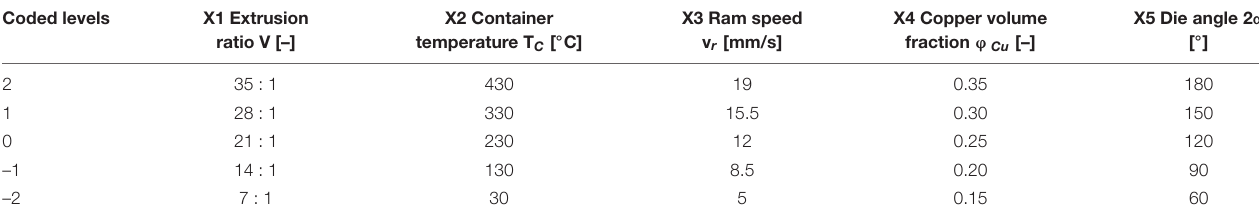
TABLE 2 | Coded levels of the five process factors in the central composite design. Coded levels